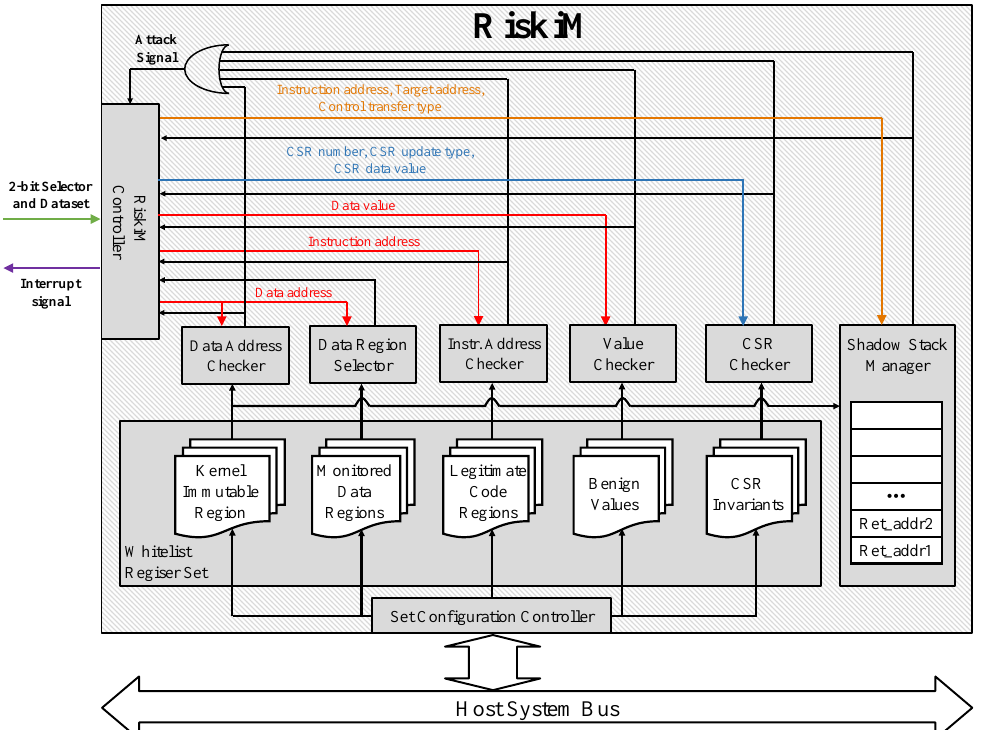
Figure 5. Microarchitecture of RiskiM